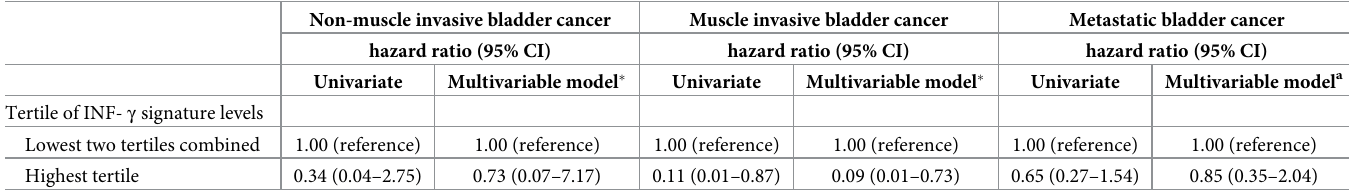
Table 2. Hazard ratios (HR) and 95% confidence intervals (CI) for the association between INF- γ signature levels and death among bladder cancer patients by stage. Mt Sinai hospital system and North Shore Long Island Jewish health system, New York, New York.